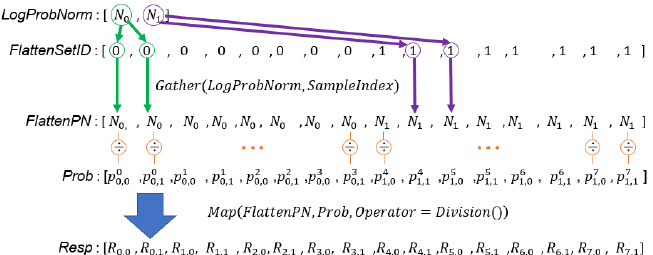
Figure 14. Illustration of the process of updating responsibilities by data-parallel